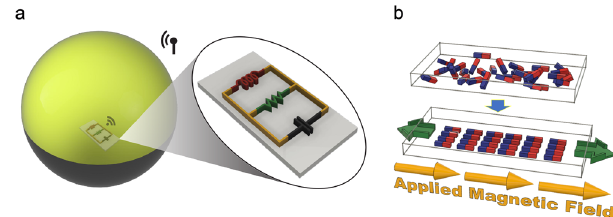
Fig. 1 | Schematic representation and operating principle of the Cell Rover. a Schematic diagram showing the wireless operation of a Cell Rover from inside a cell(Xenopusoocyte).Thezoomed inviewshowsthe CellRoverand itsequivalent circuitrepresentation asa parallelRLCresonator. b Schematic diagram illustrating the principle ofmagnetostriction. The red and blue faces indicate north and south polesofthemagneticdomainsinthematerialrespectively.Therandomlyoriented magnetic domains align in the direction of an applied magnetic fi eld which in turn causes a strain in the